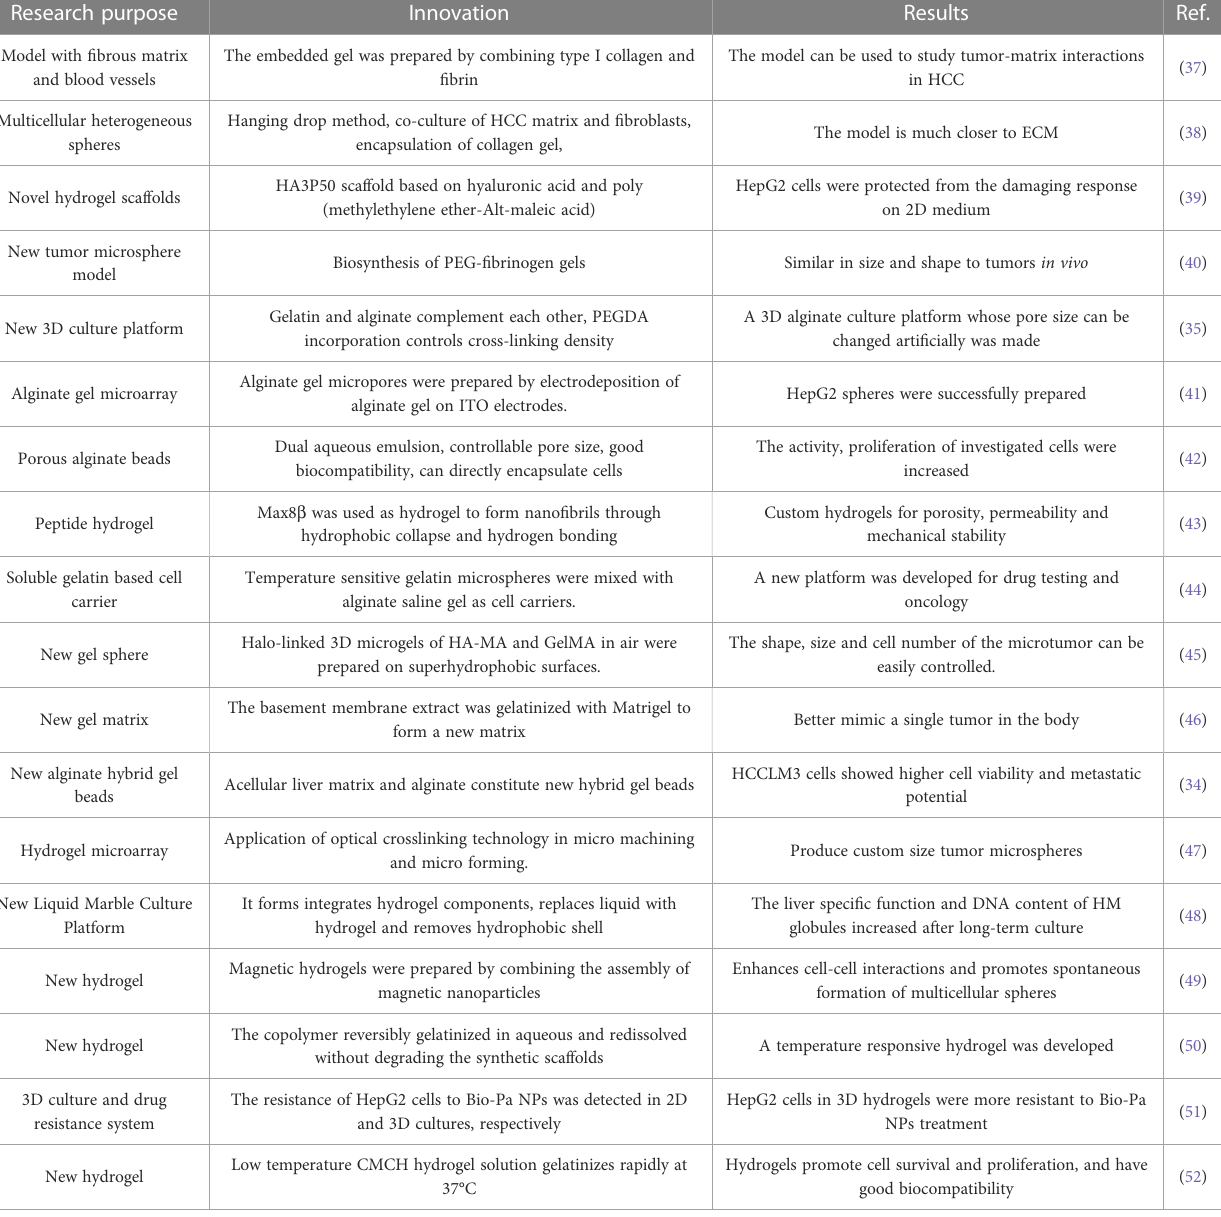
TABLE 2 New progress of hydrogel